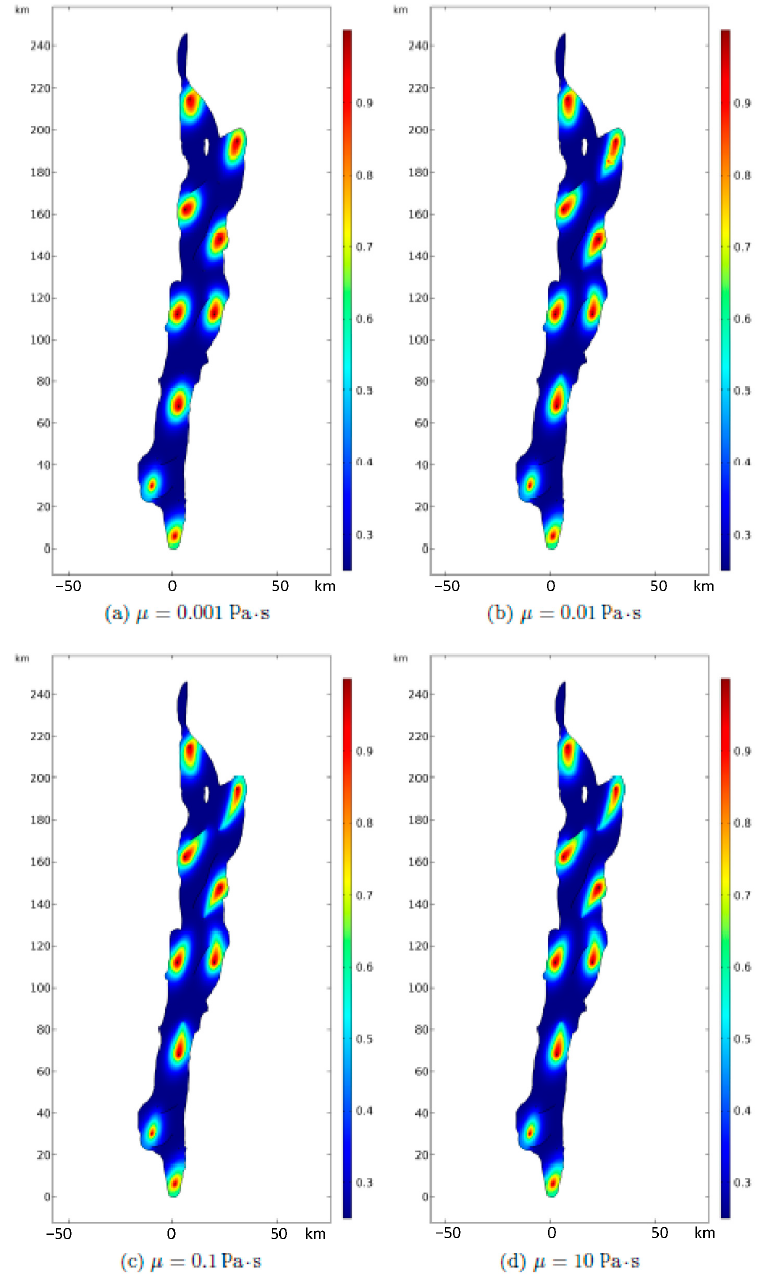
Figure 14. Normalized water saturation for different oil viscosities at the same